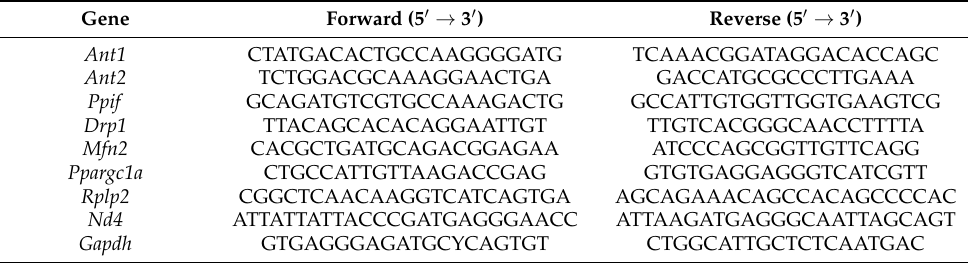
Table 1. List of gene-specific primers for RT-PCR